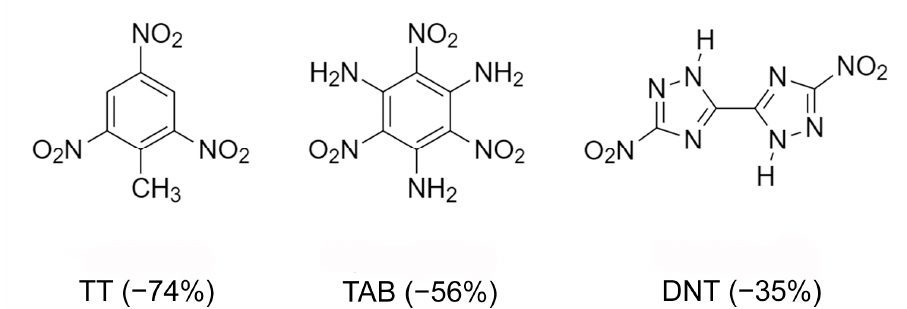
Figure 17. Chemical structure of 2,4,6-trinitrotoluene (TT), 2,4,6-triamino-1,3,5-trinitrobenzene (TAB) and DNT. Oxygen index of these compounds is given in parenthesis.